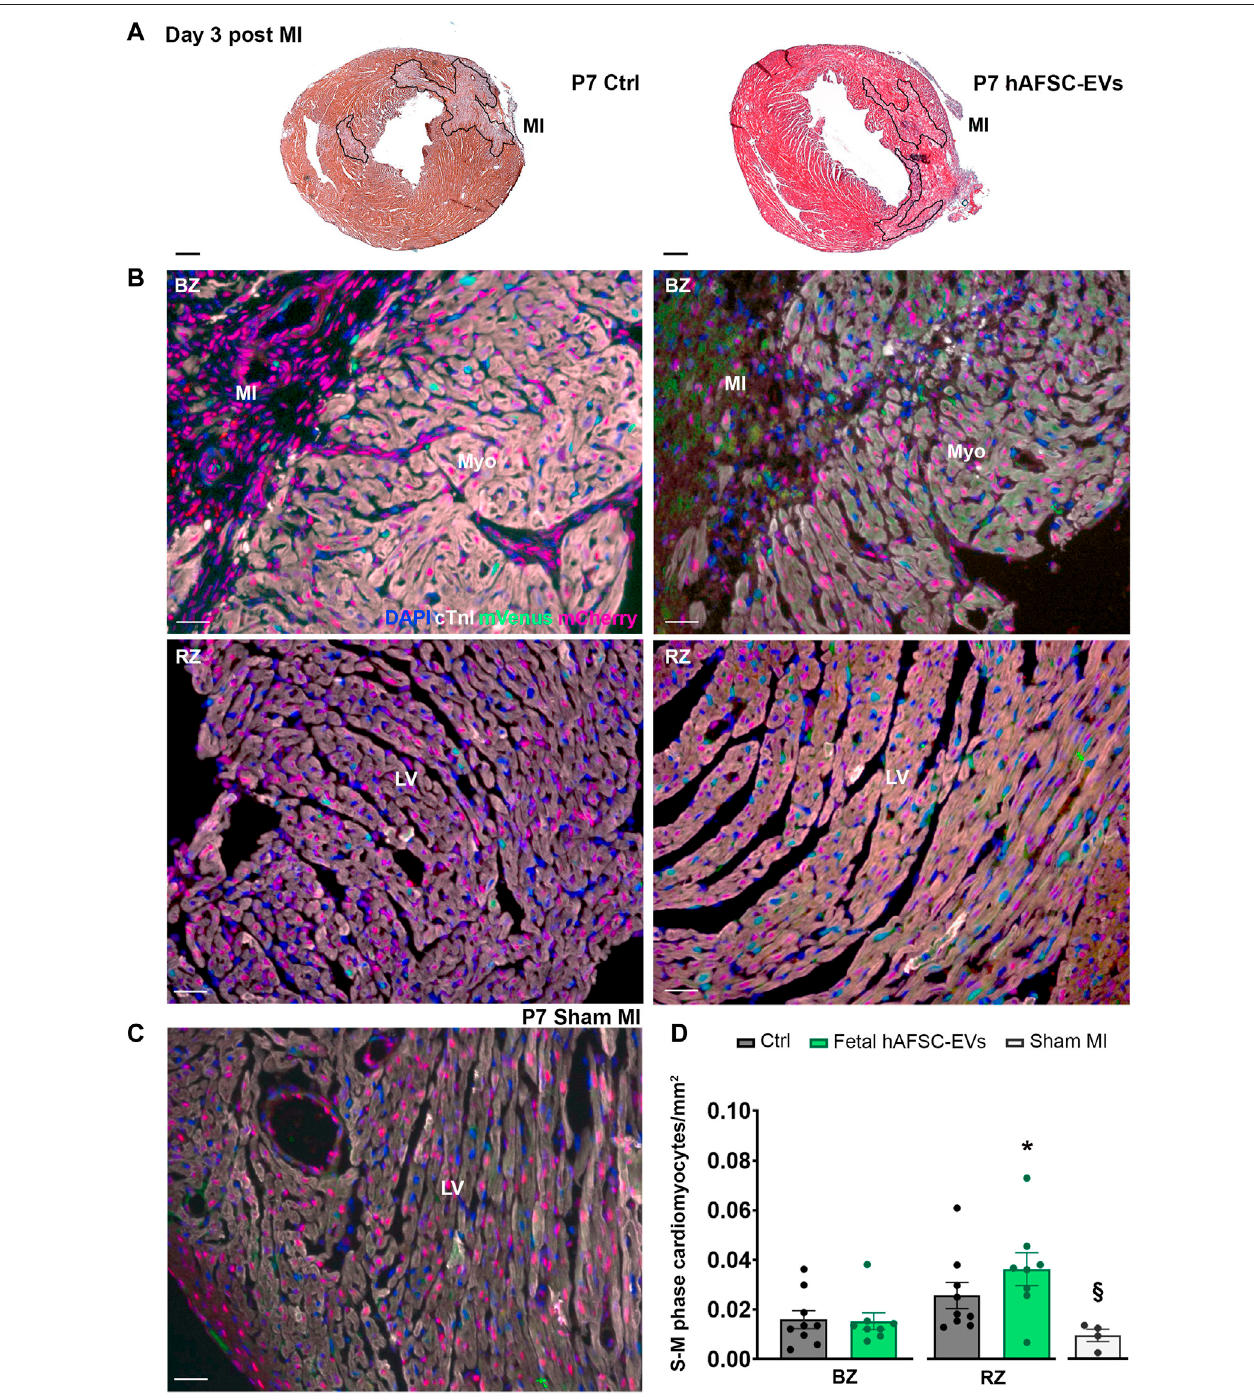
FIGURE 5 | In vivo cardiogenic effect of fetal hAFSC-EVs on P7 neonatal mouse heart at 3 days post MI. (A) Representative pictures of hematoxylin and eosin staining on cryo-sections of R26pFUCCI2 +/ − 7-day-old (P7) mouse myocardial tissue in: vehicle-treated control condition (PBS solution, left panel, Ctrl) and following intraperitonealinjectionof4.5 μ gfetalhAFSC-EVs(hAFSC-EVs,rightpanel);myocardialinfarctarea(MI)istracedinblack,scalebar:300 µm. (B) Representativepictures of immunostaining analysis on cryo-sections of R26pFUCCI2 +/ − 7-day-old (P7) mouse myocardial tissue in: vehicle-treated control conditions (PBS solution, left panel, Ctrl), following intraperitonealinjection with4.5 μ gfetal hAFSC-EVs(hAFSC-EVs, right panel) orin Sham controlconditions [ (C) , Sham MI,for DAPI(blue), cardiac troponin I (cTnI, white), mVenus-Geminin (mVenus, green), and mCherry-Cdt1 (mCherry, red), at 3 days post MI (P7 d3), scale bar: 50 µm. (D) Evaluation of mVenus- positive and cTnI-positive resident cells (S-M phase cardiomyocytes/mm 2 ) receiving hAFSC-EVs treatment compared to vehicle Ctrl solution in the MI border zone (BZ,